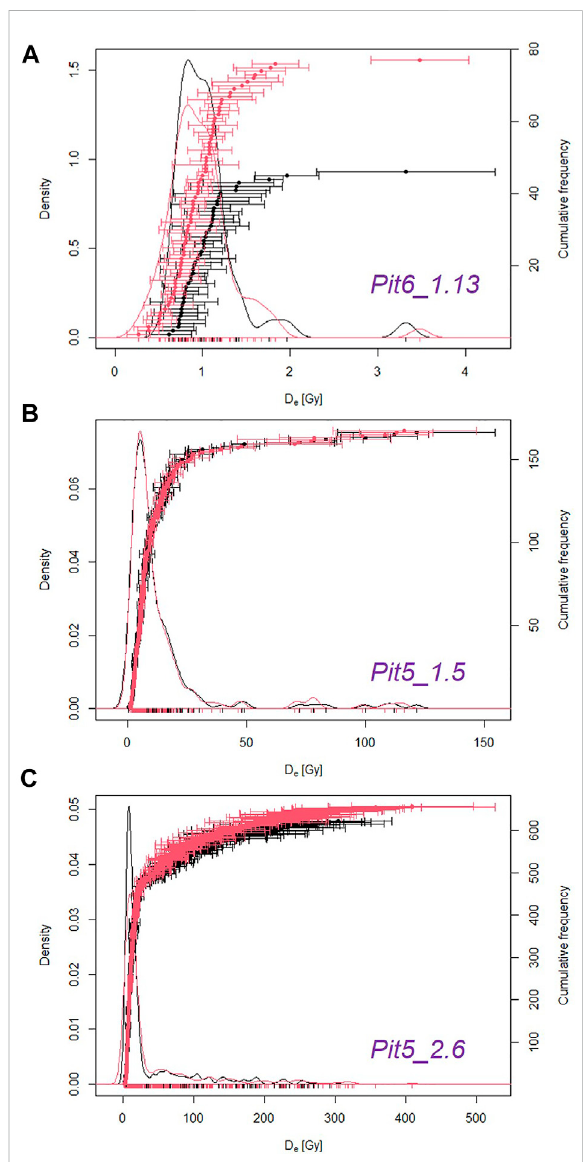
FIGURE 3 Comparison of the D e values derived using SAR DRCs (black color) and those derived using rSGCs ( σ b =0, red color). (A) Sample Pit 6_1.13; (B) Sample Pit5_1.15; (C) Sample Pit5_2.6.